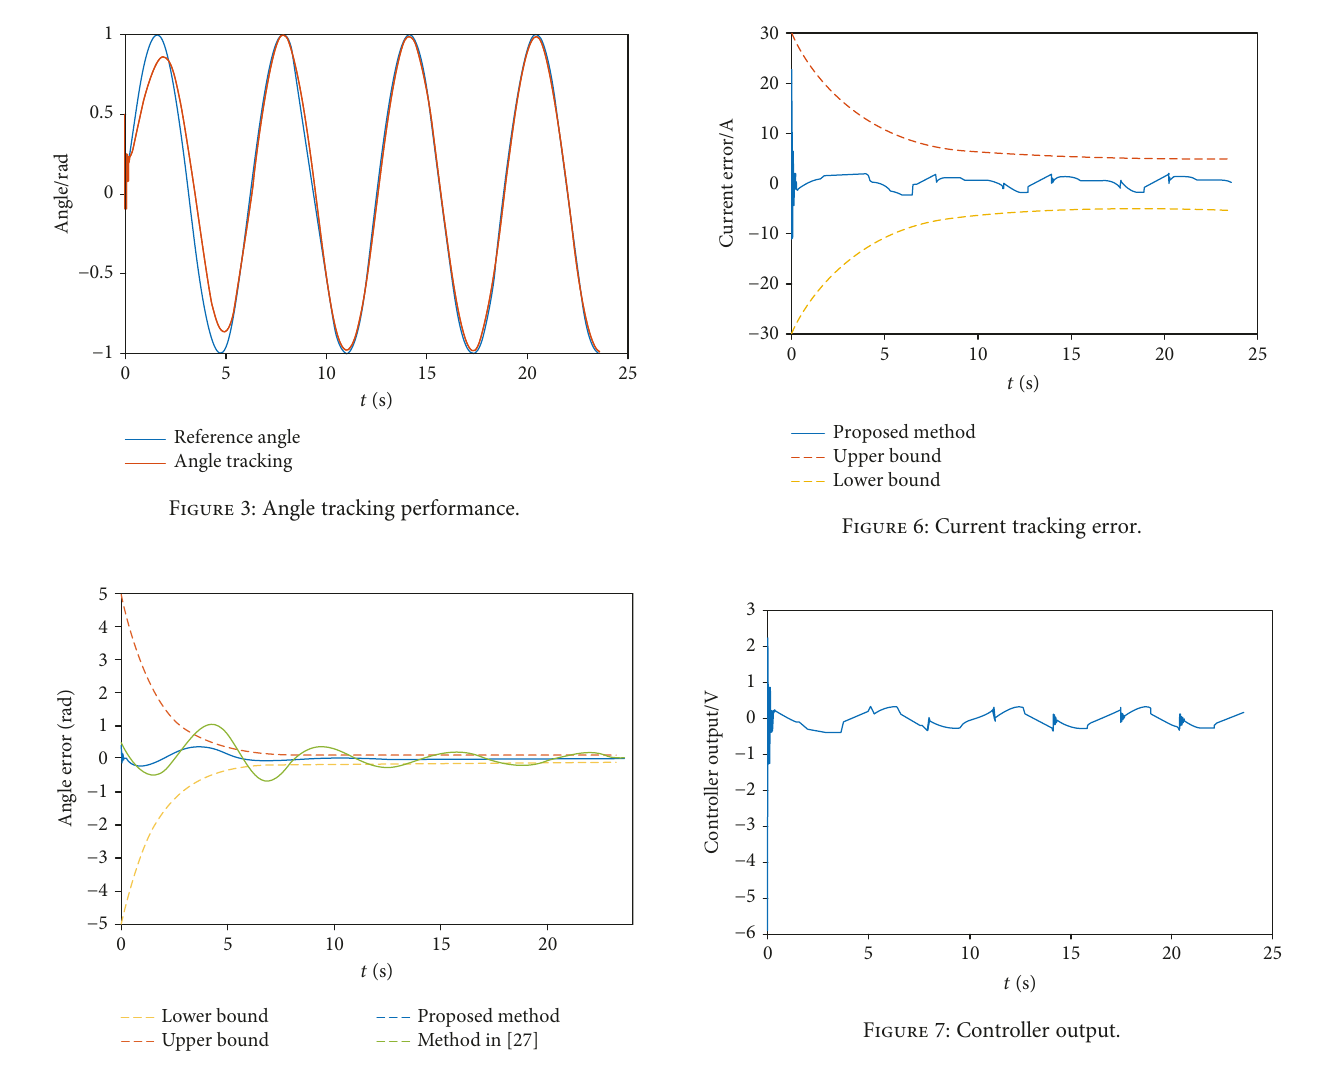
Figure 4: Angle tracking error.